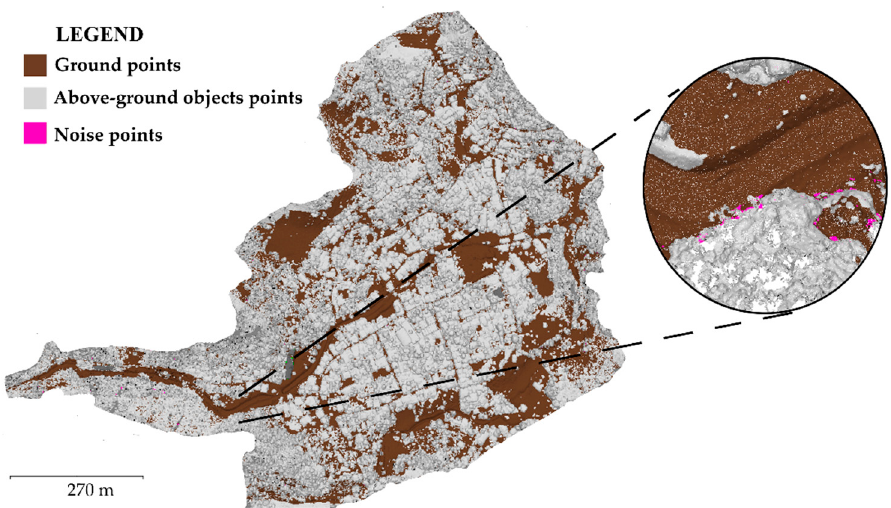
Figure 7. Dense point cloud classification.